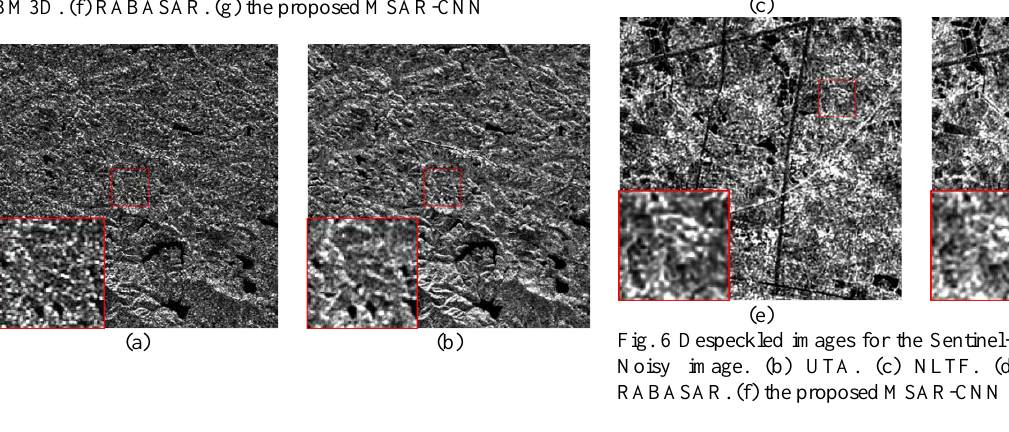
Fig. 4 Despeckled images for the simulate realistic image. (a) Noisy image. (b) Truth image. (c) UTA. (d) NLTF. (e) MSAR- BM3D. (f) RABASAR. (g) the proposed MSAR-CNN